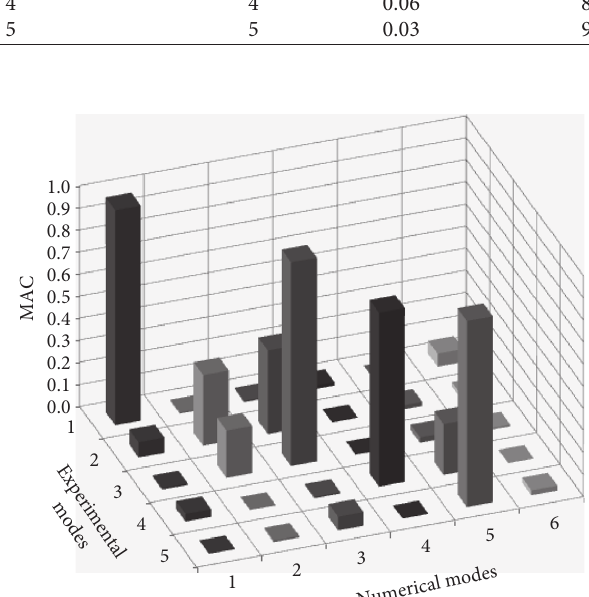
Figure 9: Model without the underground story: histogram rep- resentation of the MAC matrix for the optimal value of w / d � 0.24.